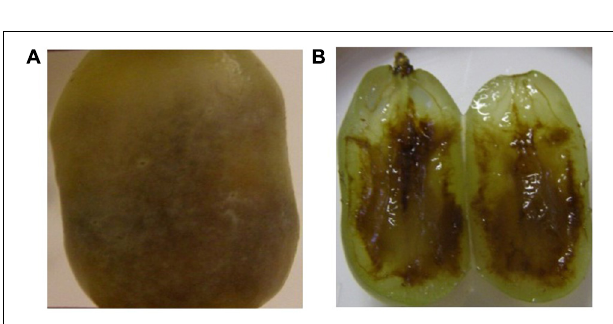
FIGURE 6 | Internal browning as seen (A) from the outside and (B) on the inside of a ‘Thompson Seedless’ berry.